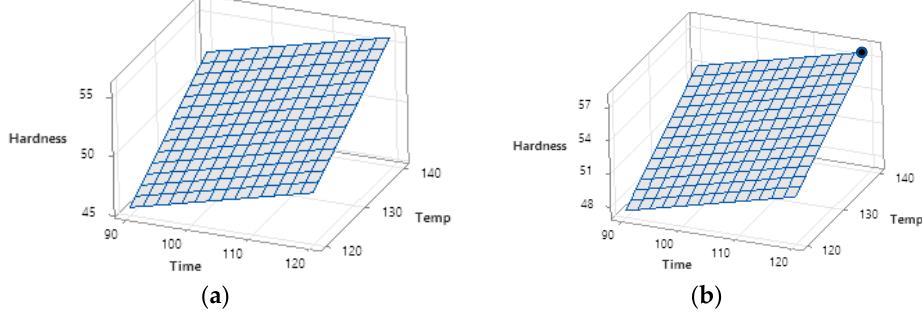
Figure 11. Surface plots of hardness ( HD ) at a constant pressure of ( a ) 3 bar; ( b ) 7 bar. Hardness was observed to increase with temperature, time, and pressure. The optimum hardness was observed at CC8 (140 ◦ C, 120 min, and 7 bar), represented by a black